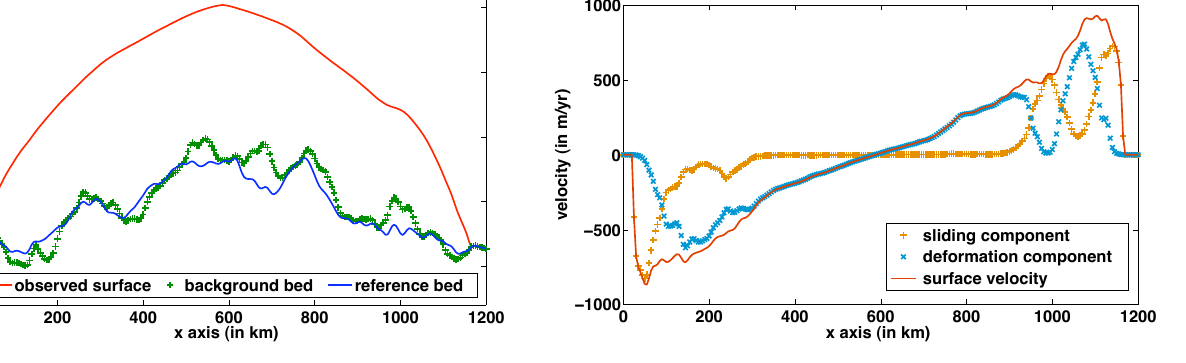
Fig. 2. Ice sheet geometry for the reference and background states. The x axis represents the horizontal extent of the ice sheet (in km). The y axis is the elevation in metres from the sea level. The refer- ence bedrock topography is in blue, the background bedrock is in green crosses. Reference and background surface altitude are iden- tical, in red.